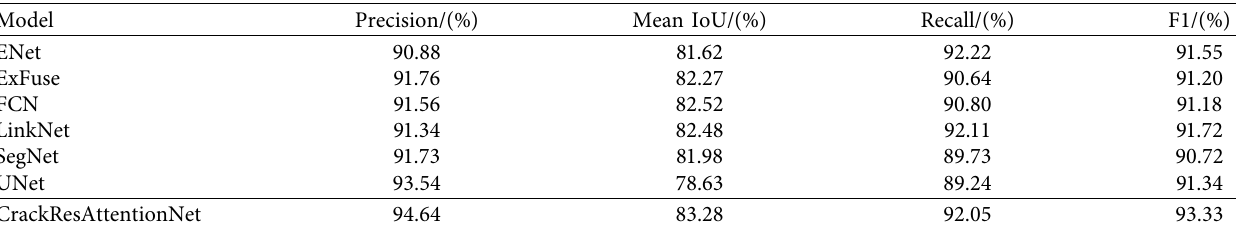
Table 6: Yantai Dataset–CE